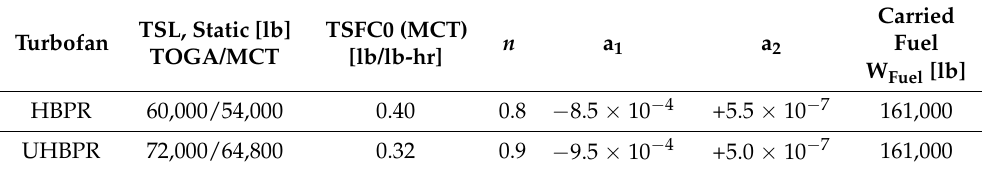
Table 3. Basic data for flat-rated turbofan engines model